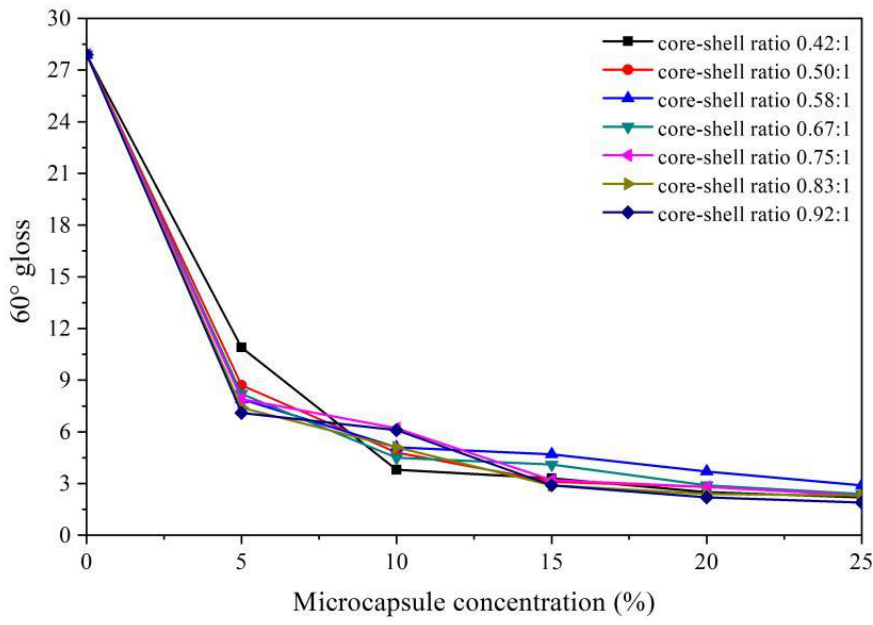
Figure 2. Effect of microcapsule concentration and core-shell ratio on gloss of paint film.